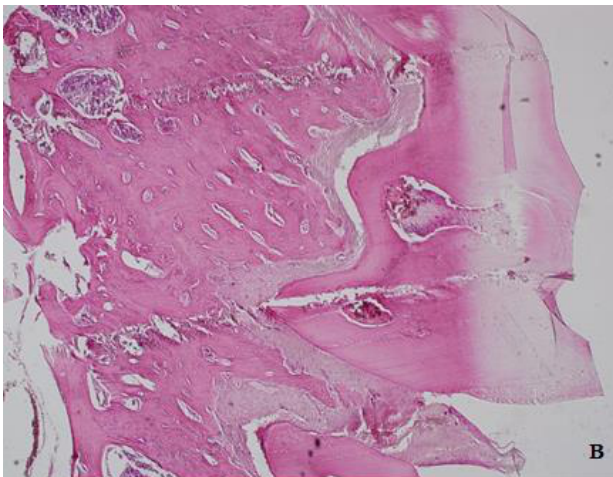
Fig. 3. Mesial root, alveolar process & furcation (A), Distal root, alveolar process & furcation (B) of first rat molar and its periodontium. Note the organized collagen fibers with no inflammation and no bone resorption (H&E staining, 100X).